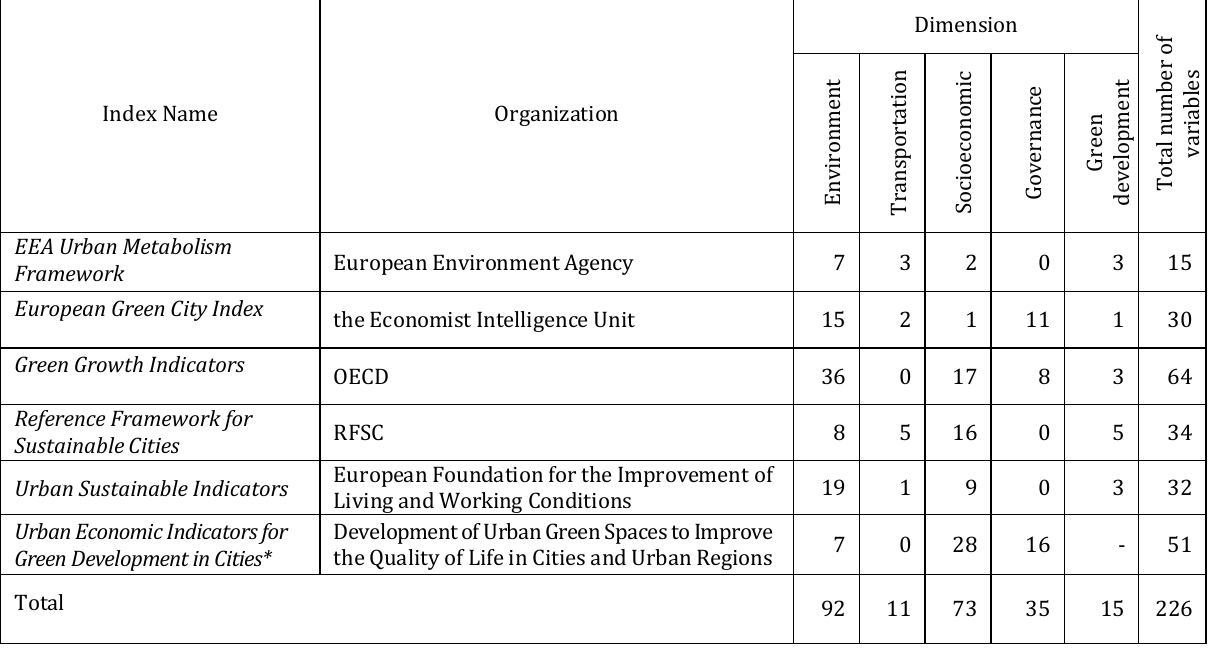
Table 2. Dimensions of the Sustainable City (Source: own